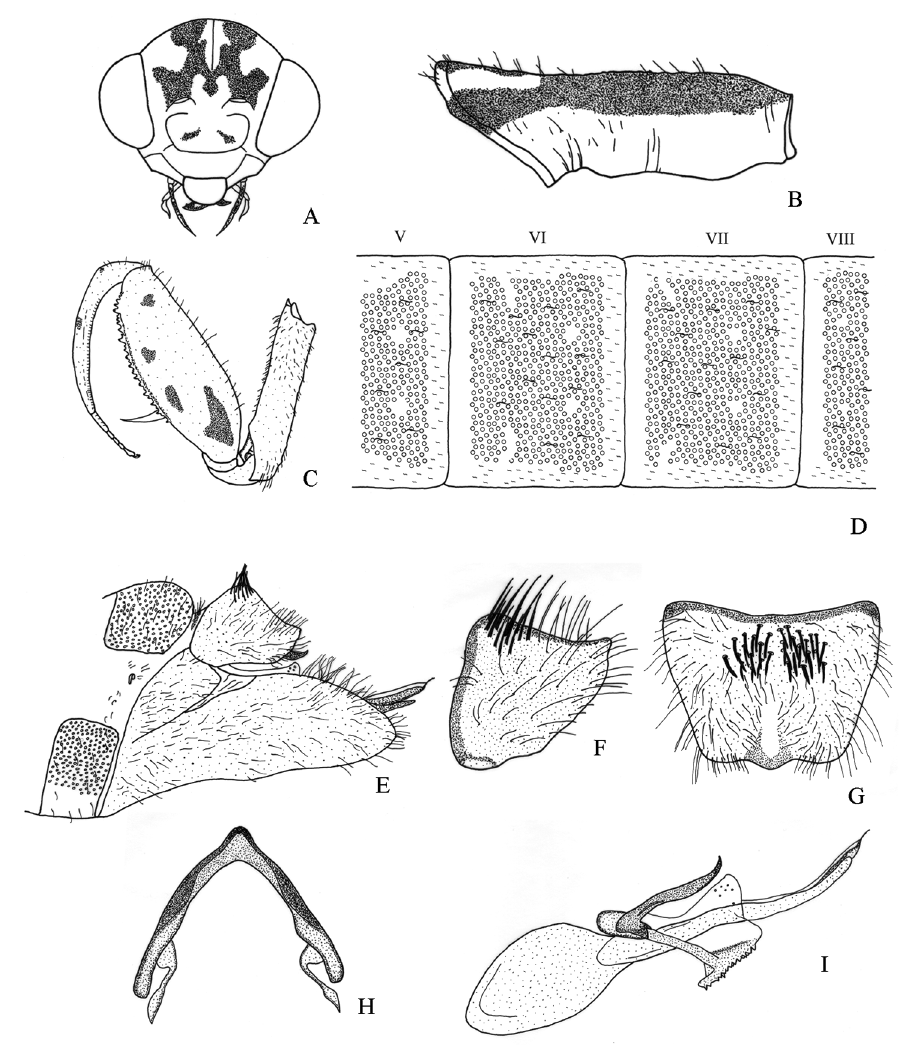
Figure 8. Structures of the male of Nolima infensa . A head, frontal B prothorax, lateral C left foreleg, lat- eral D abdominal terga V–VIII, dorsal E external terminalia, lateral F left ectoproct, lateral G ectoprocts, dorsal H gonarcus, dorsal I internal terminalia,